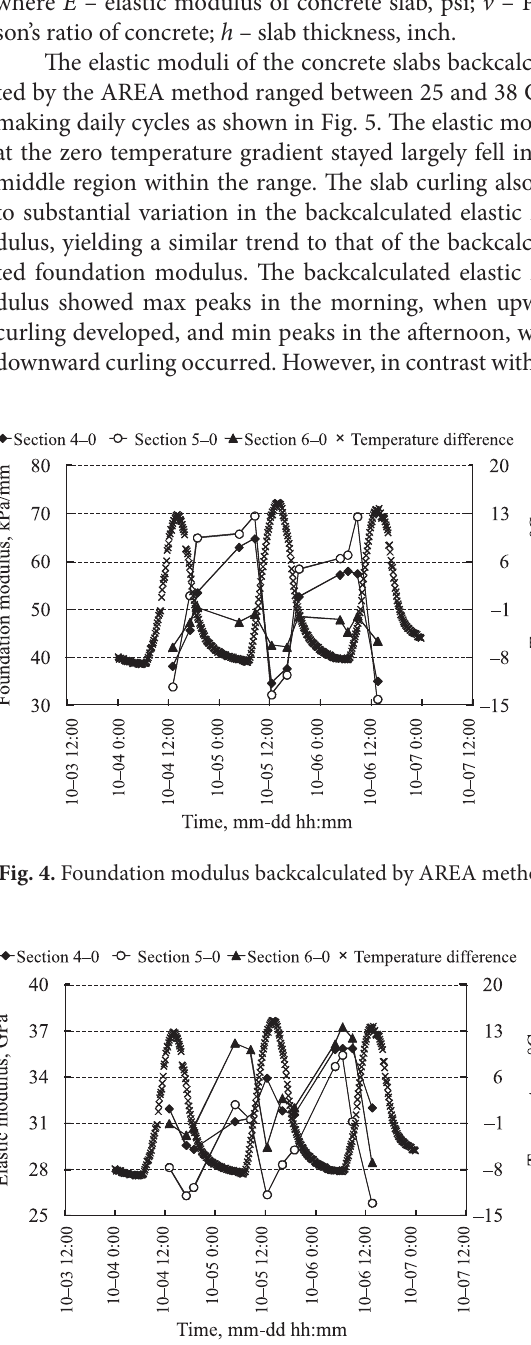
Fig. 5. Elastic modulus of concrete slab backcalculated by AREA